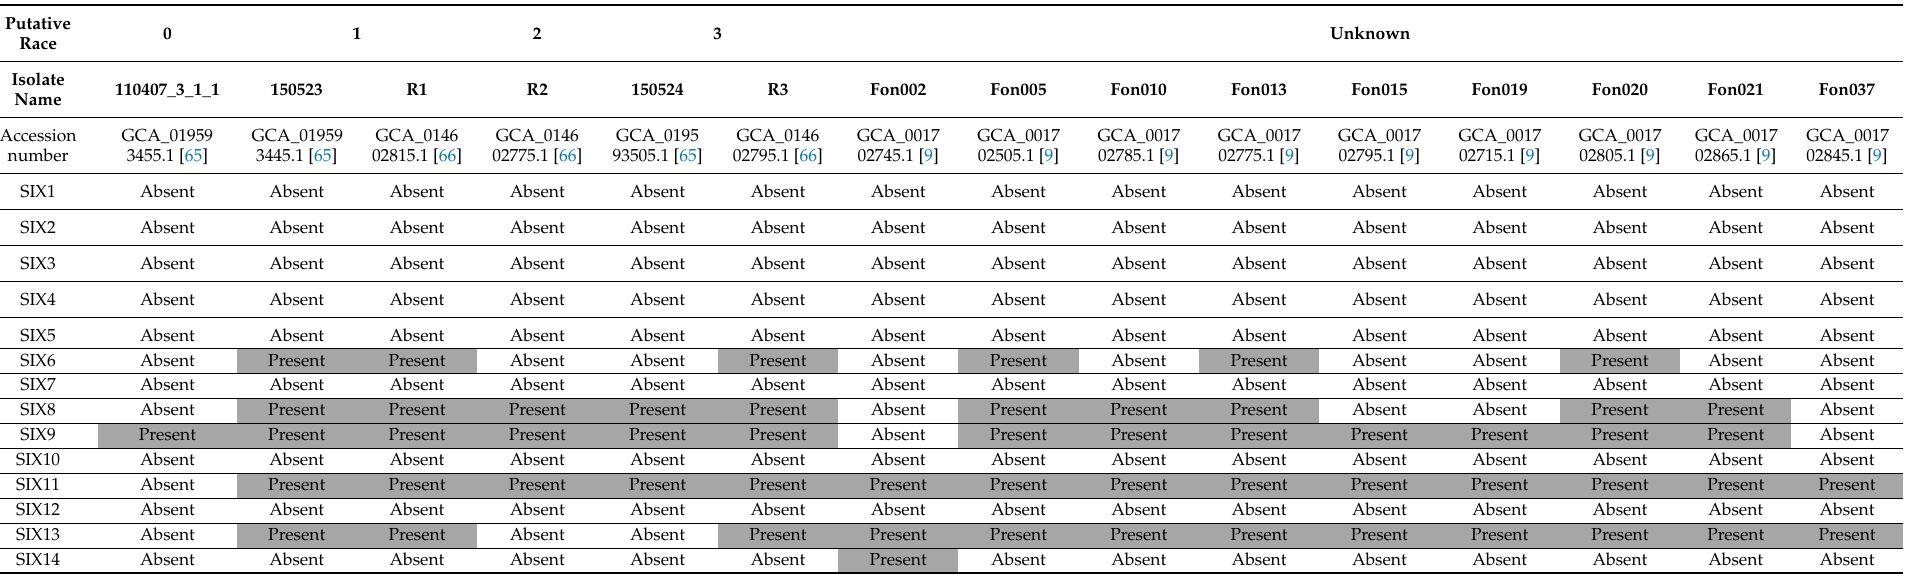
Table 4. Secreted-in-xylem (SIX) effector profile for Fusarium oxysporum f.sp. niveum (Fon) isolates taken from whole genome